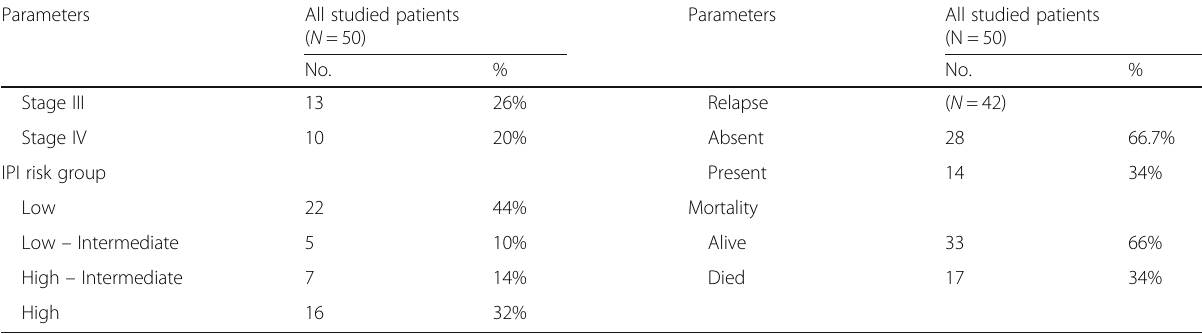
Table 1 Clinicopathological features, PDL1, FOXP1, STAT3 expression and outcome of our patients